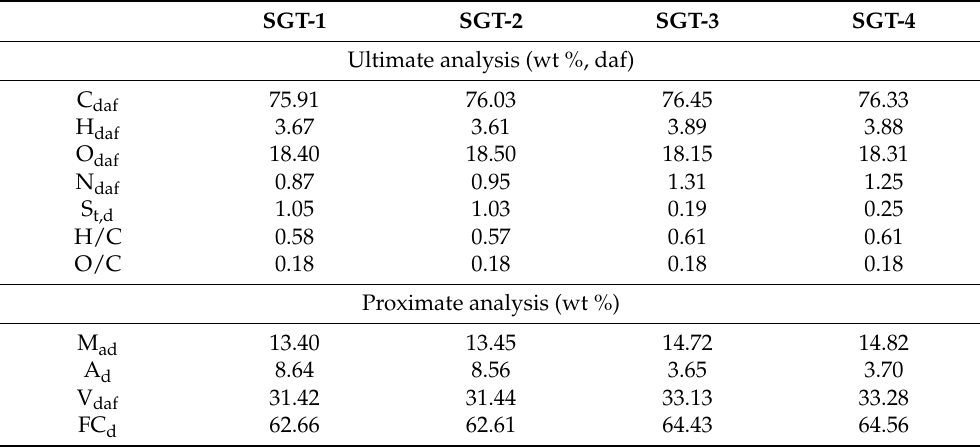
Table 3. Proximate and ultimate analyses of coal samples.